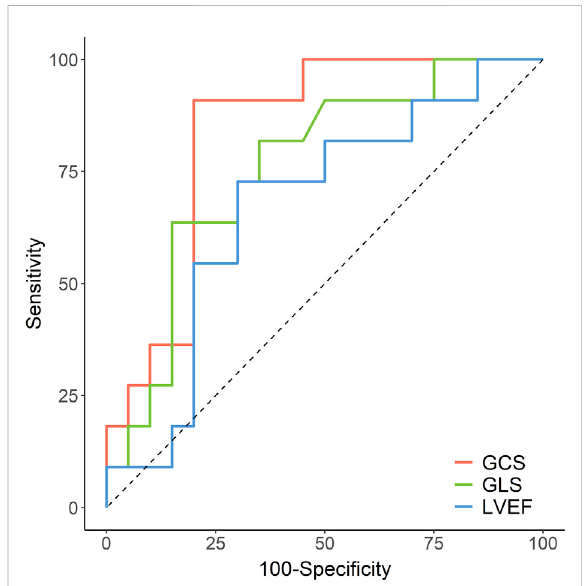
FIGURE 4 ReceiveroperatingcharacteristiccurvesforaccuracyofGCS, GLS and LVEF in the prediction of LGE > 25%. GCS, global circumferential strain; GLS, global longitudinal strain; LVEF, left